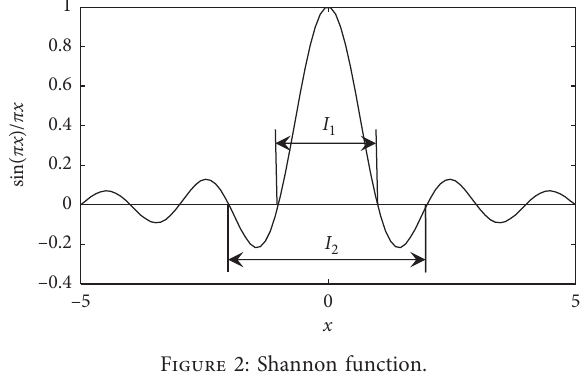
Figure 2: Shannon